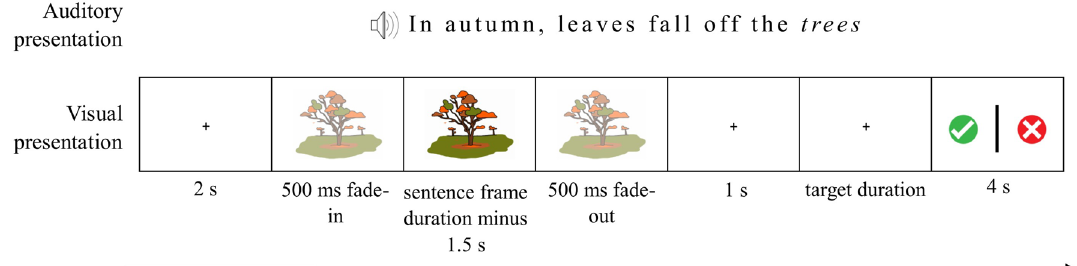
Figure 1. Trial sequence on a question trial. Note that the same animation would be presented for the incongruent version of this sentence (“in autumn, leaves fall of the dishes ”). On non-question trials the final display was not shown and the 2 s ITI started immediately. Images were drawn and digitised by Gabriella